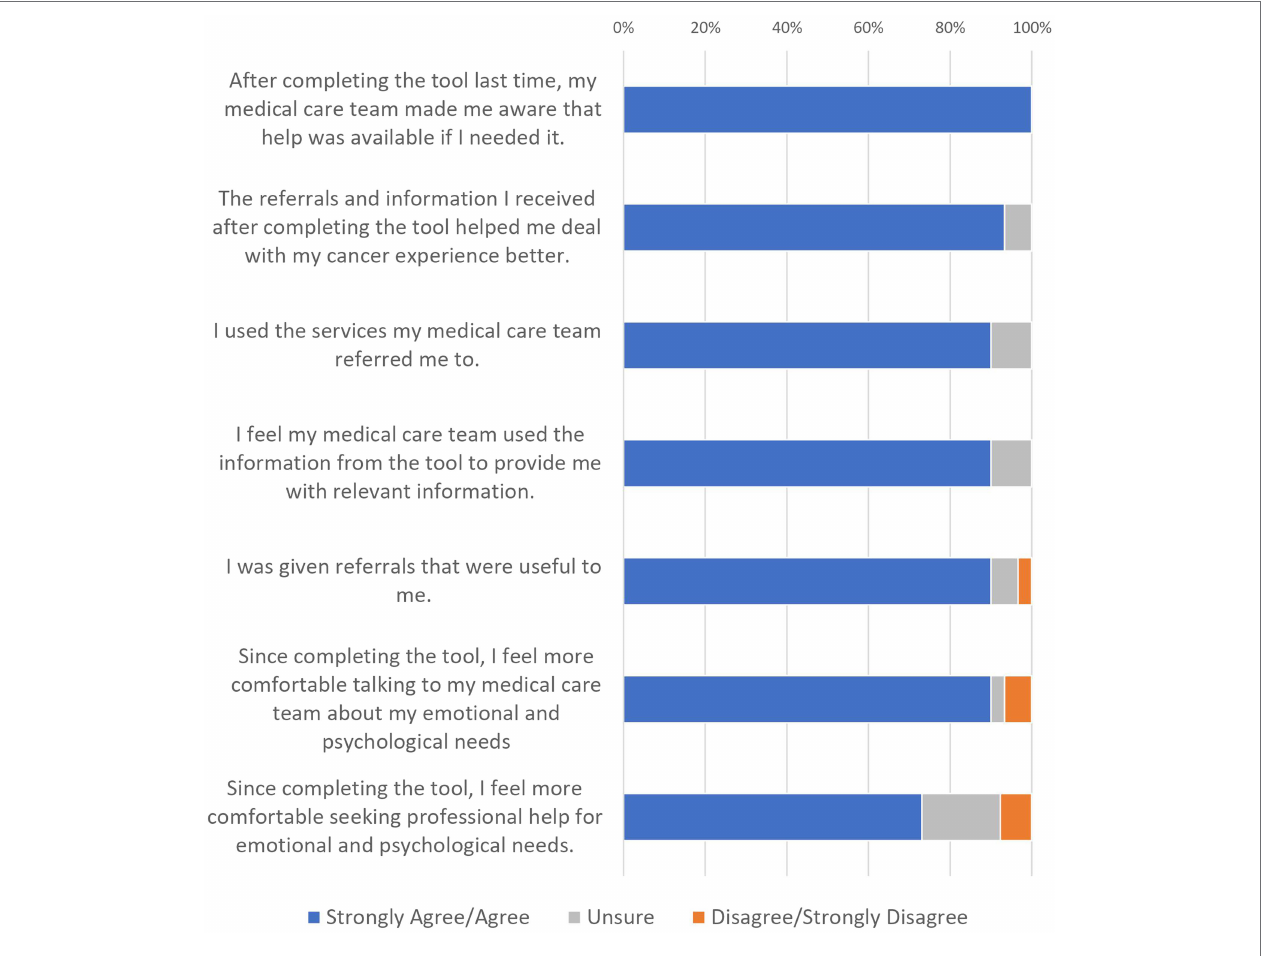
FIGURE 2 | AYA ratings of service responsiveness since completing the